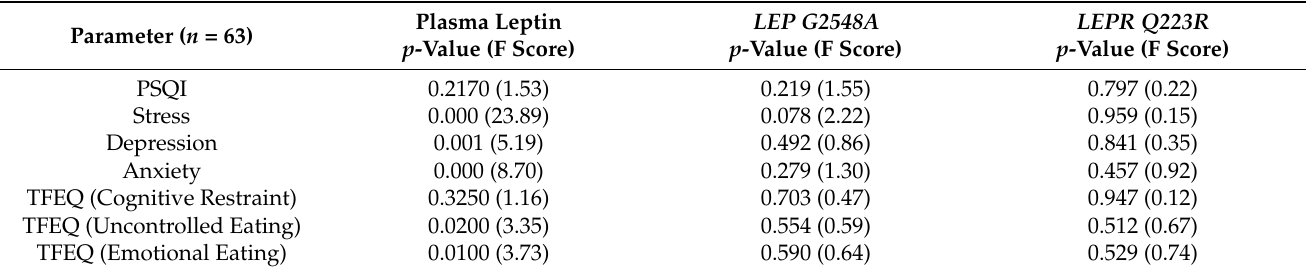
Table 5. ANOVA test result of leptin, G2548A LEP , and Q223A LEP R polymorphisms with associated risk